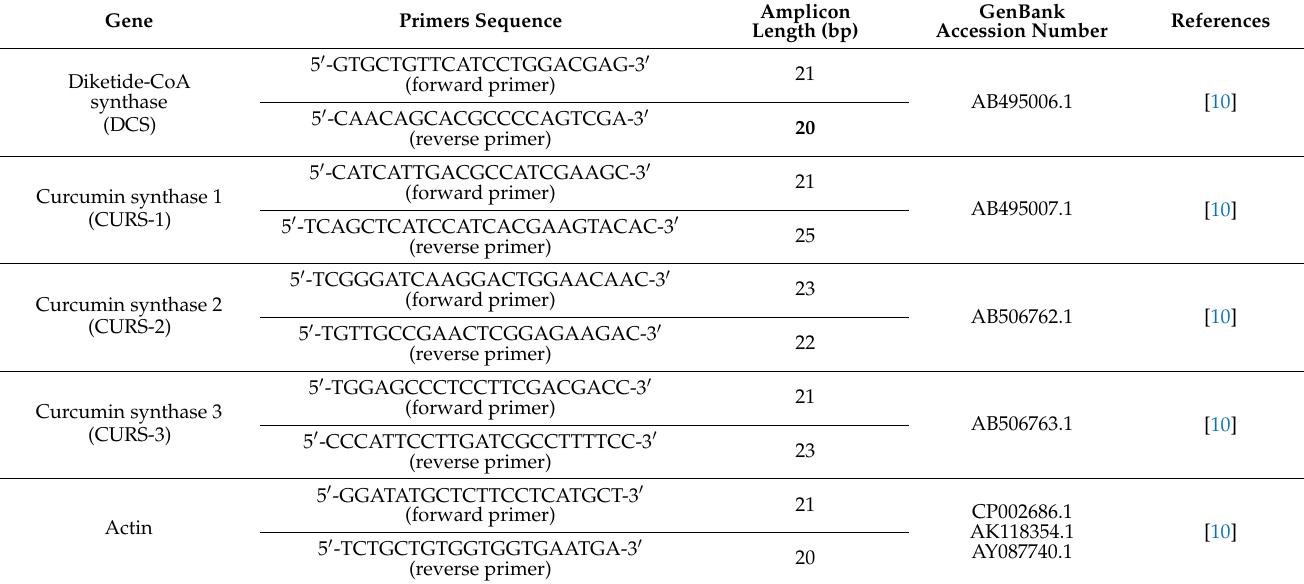
Table 4. Sequences of forward and reverse primers for real-time